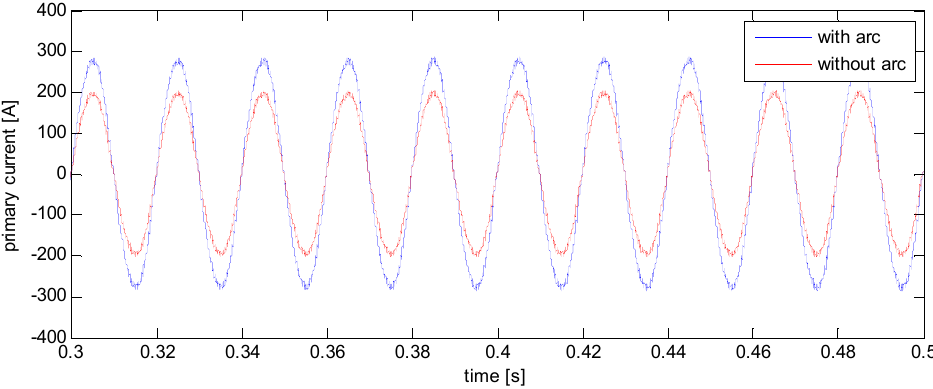
Figure 10. Primary current of the traction